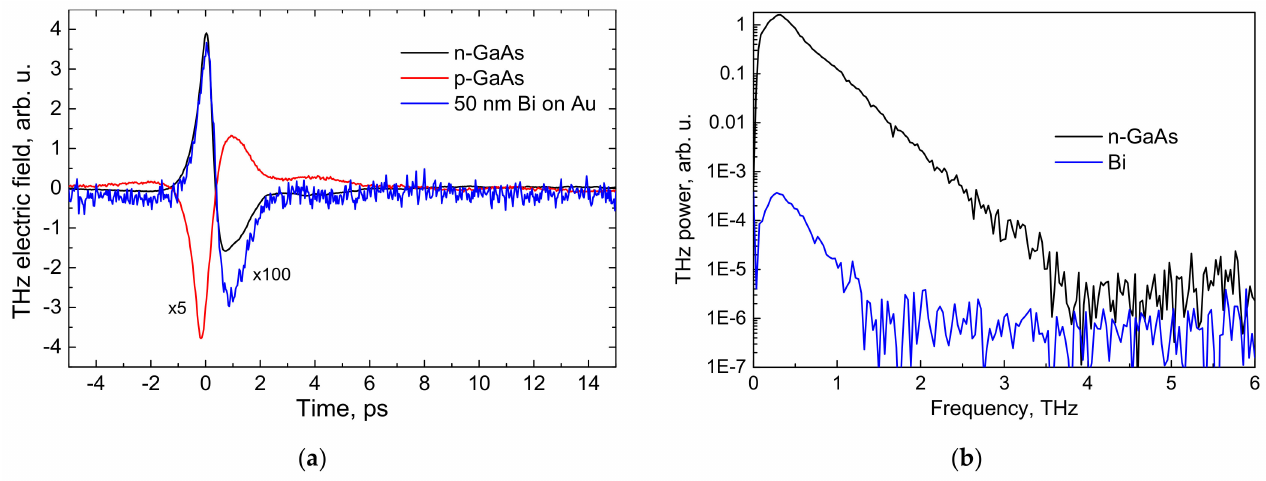
Figure 5. THz pulses ( a ) and their Fourier spectra ( b ) radiated from n -type GaAs ( n = 2 × 10 18 cm − 3 , black line), p -type GaAs ( p = 4 × 10 18 cm − 3 , red line) single crystals and from the surface of a 50 nm thick Bi on Au layer (blue line). The optical pulse wavelength was 780 nm, and the average power of the beam was 300